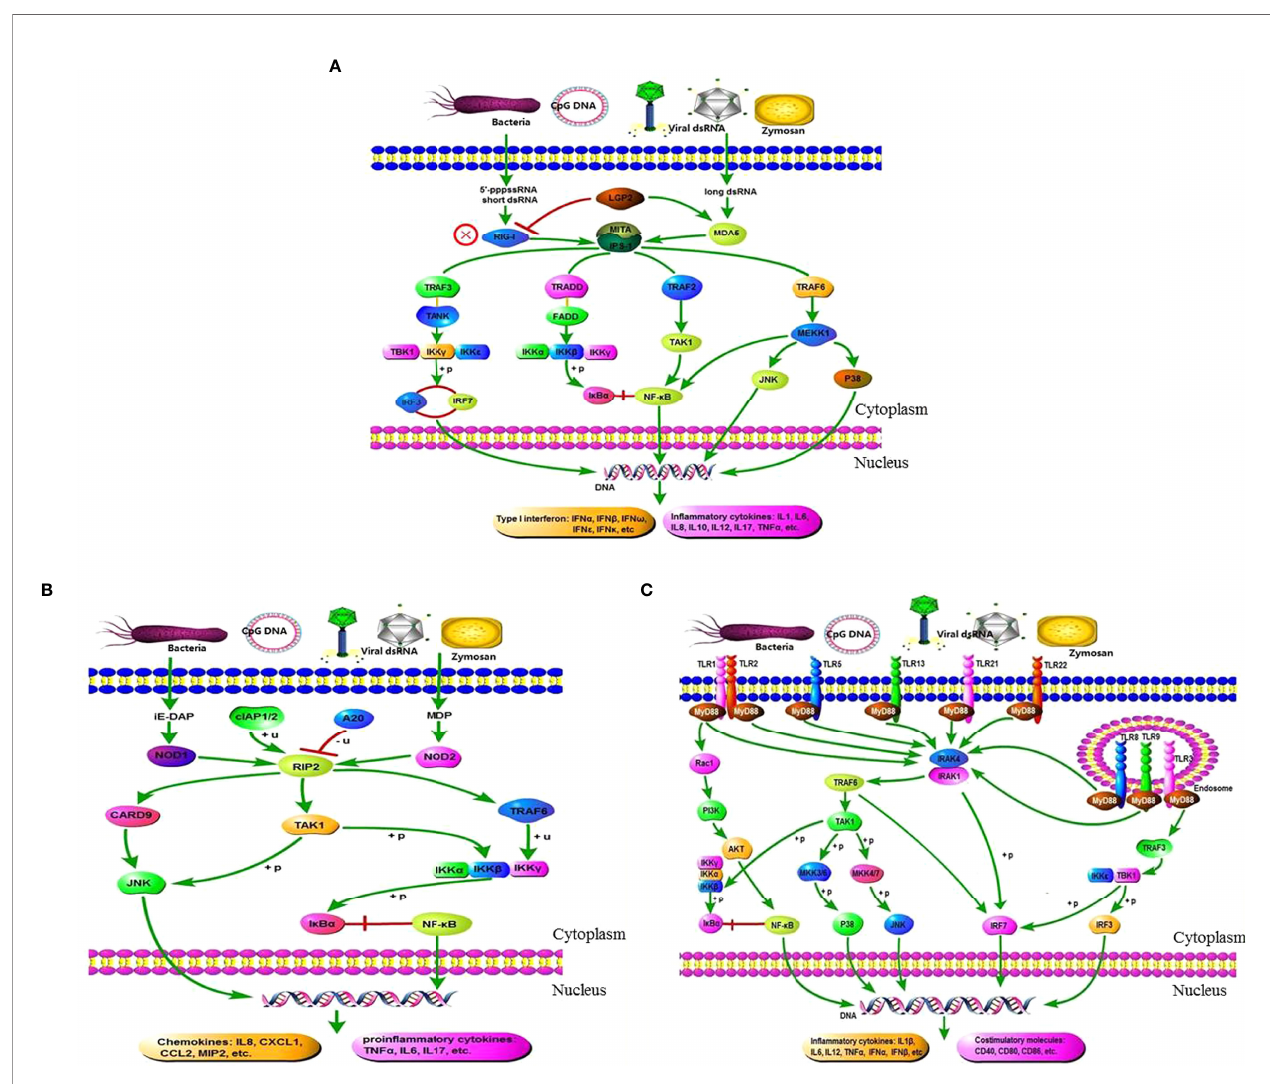
FIGURE 8 | Exhibition of the three pattern recognition receptor signaling pathways and their mediated immunomodulatory effects in the DI tissues of SBMIE pearl gentian grouper. (A) There is no RIG-I gene in pearl gentian grouper, and the RIG-I like receptor signaling pathway was activated through MDA5 route; (B) there are several co-contained genes in the three PRR signaling pathway, indicating the interactions among them, and fi nally culminated in the transcriptome activation of NF- k B, IRFs, costimulatory molecules, etc., and fi nally promoted the expression of proin fl ammatory cytokines, interferons (IFNs), chemokines, and other molecules necessary for innate and/or adaptive immune responses. (A) RIG-like receptor signaling pathway. (B) NOD-like receptor signaling pathway. (C) Toll-like receptor signaling